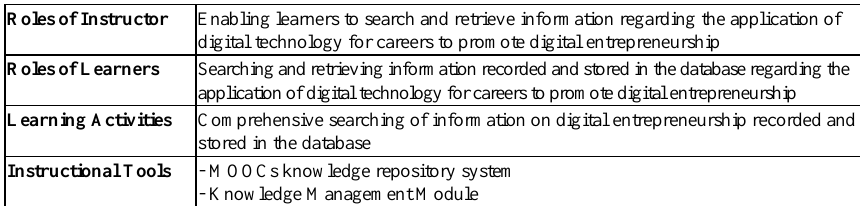
Table 3. Knowledge Acquisition